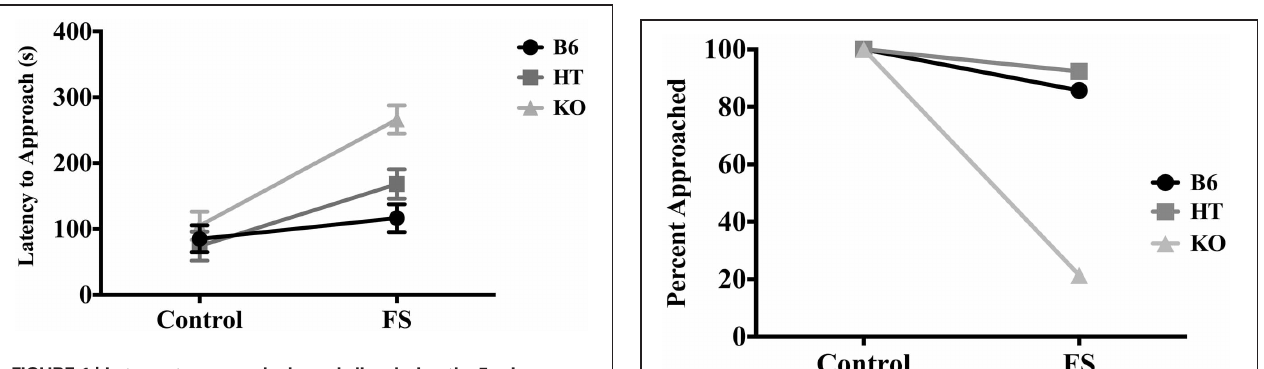
FIGURE 1 | Latency to approach almond slice during the 5-min novelty-suppressed feeding (NSF) test in wild-type C57BL/6J (B6), heterozygous (HT), and β -E knock-out (KO) mice, following either 10min single housing (Control) or 3min of forced swim, followed by 7min single housing (FS). Data show mean ± SE. Significant differences ( p -values ≤ 0.05) between groups were determined following ANOVA by post-hoc analysis (Fisher’s LSD test). There were main effects of the FS stressor, genotype, and an interaction between stress condition and genotype.